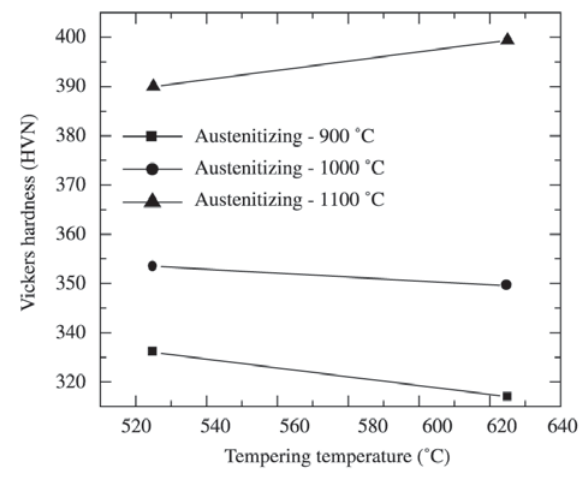
Figure 5. Evolution of hardness with time of intercritical treat- ment.